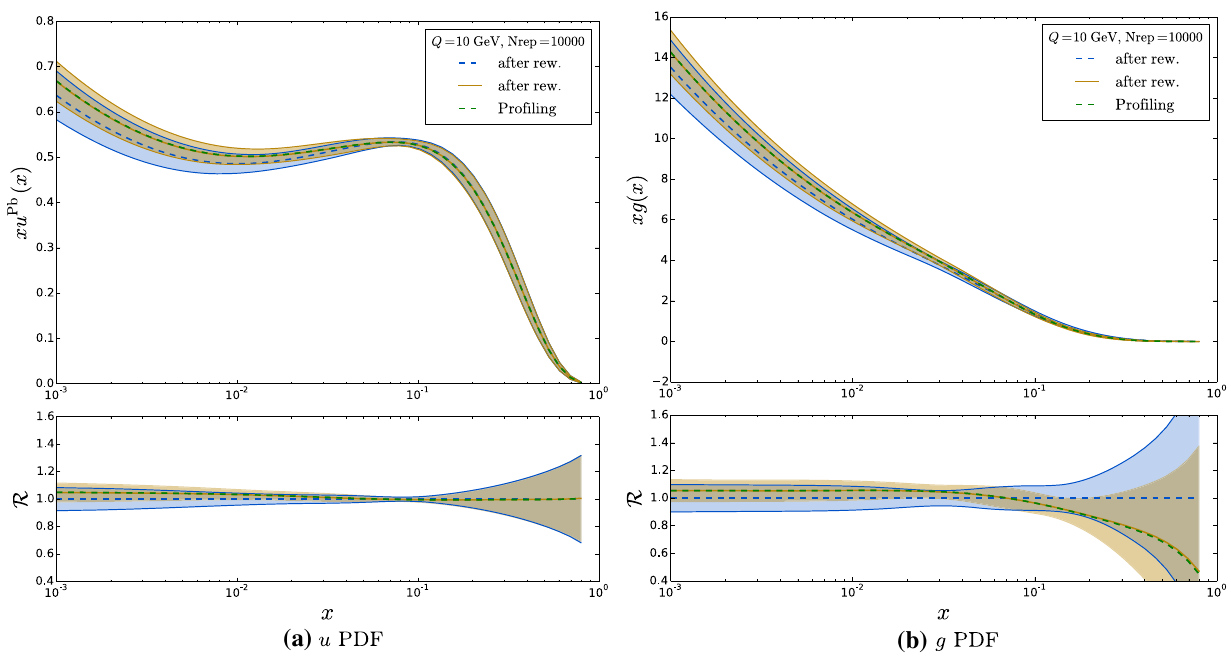
Fig. 19 Comparison of PDFs at Q = 10GeV before and after the reweighting procedure using only the CMS rapidity distribution data set. The lower plots show the ratio compared to the central (average) distribution before the reweighting